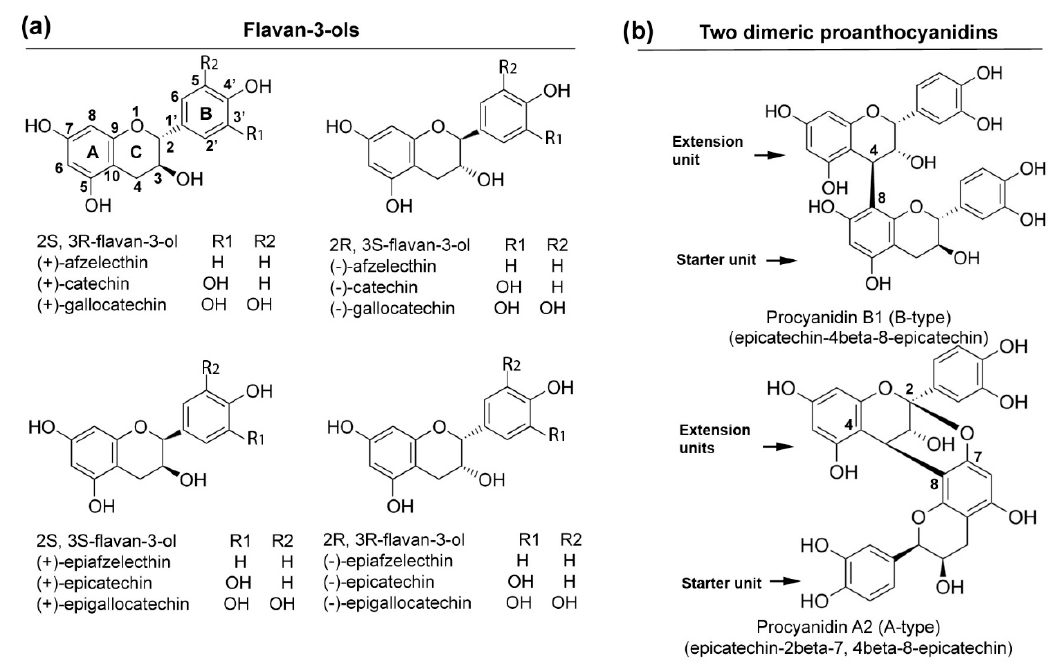
Figure 1. Schemes of flavan-3-ols (monomers) and dimeric proanthocyanidins: ( a ) four types of stereo configurations of different monomeric flavan-3-ols, such as (+)-catechin, ( − )-epicatechin, ( − )-epigallocatechin, and ( − )-epicatechin; ( b ) two examples of dimeric proanthocyanidins, procyanidin A2 (A-type) and procyanidin B1 (B-type).